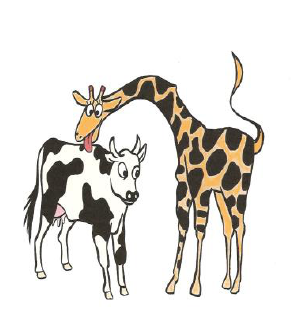
Figure 2. A pseudocleft experimental